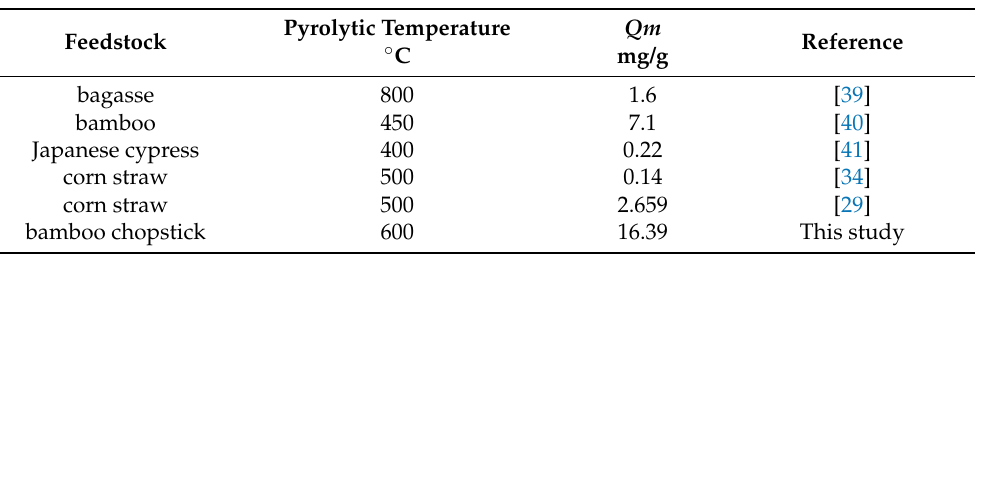
Table 4. The maximum adsorption capacity for nitrate of reported